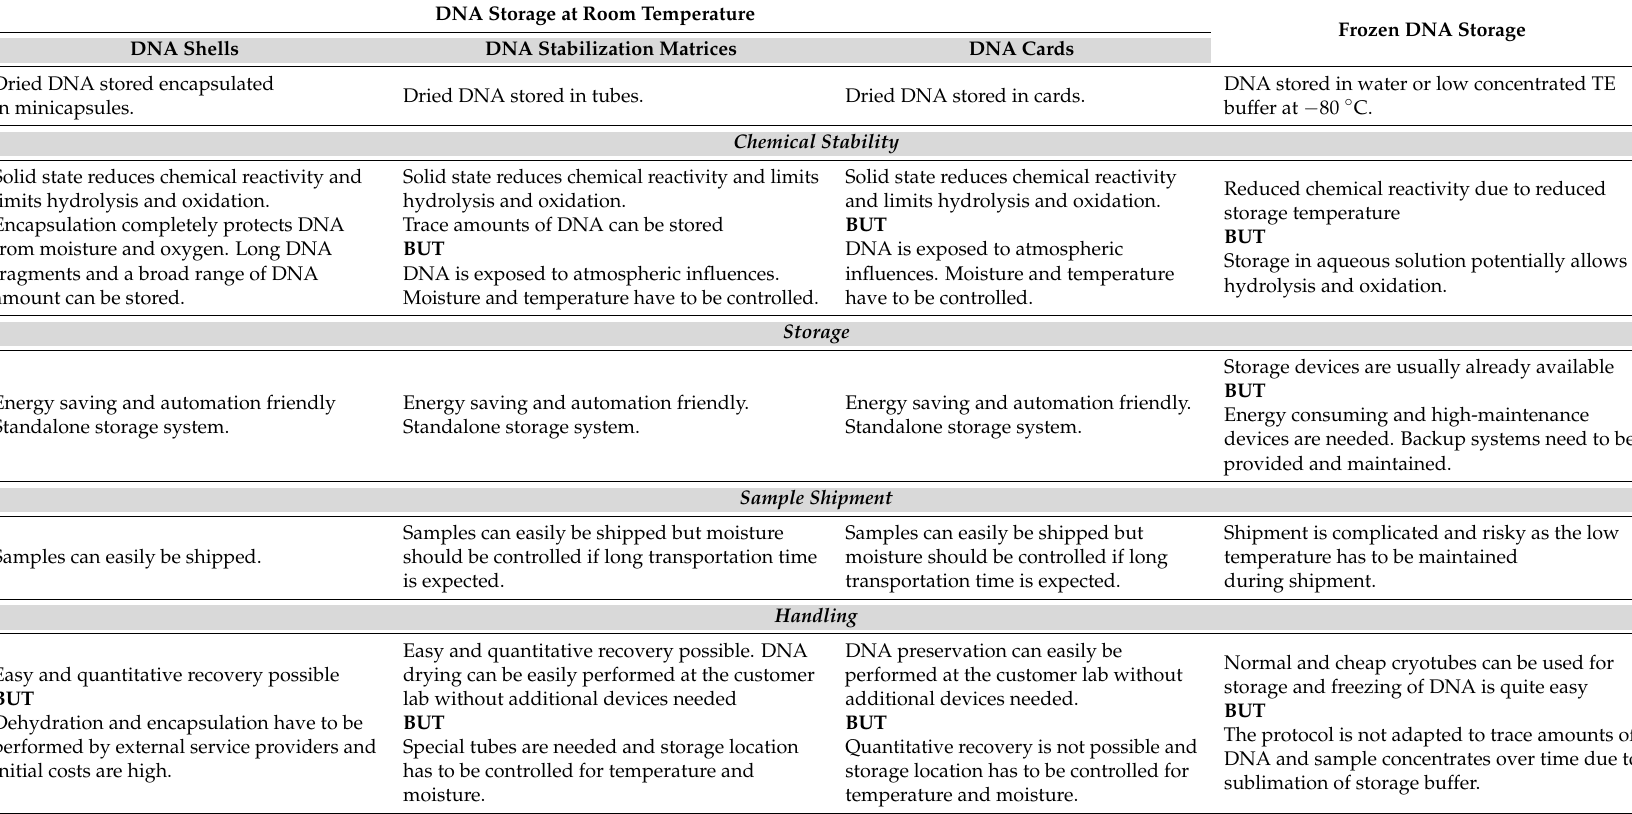
Table 4. Advantages and disadvantages of DNA storage at room temperature according to different technologies versus frozen